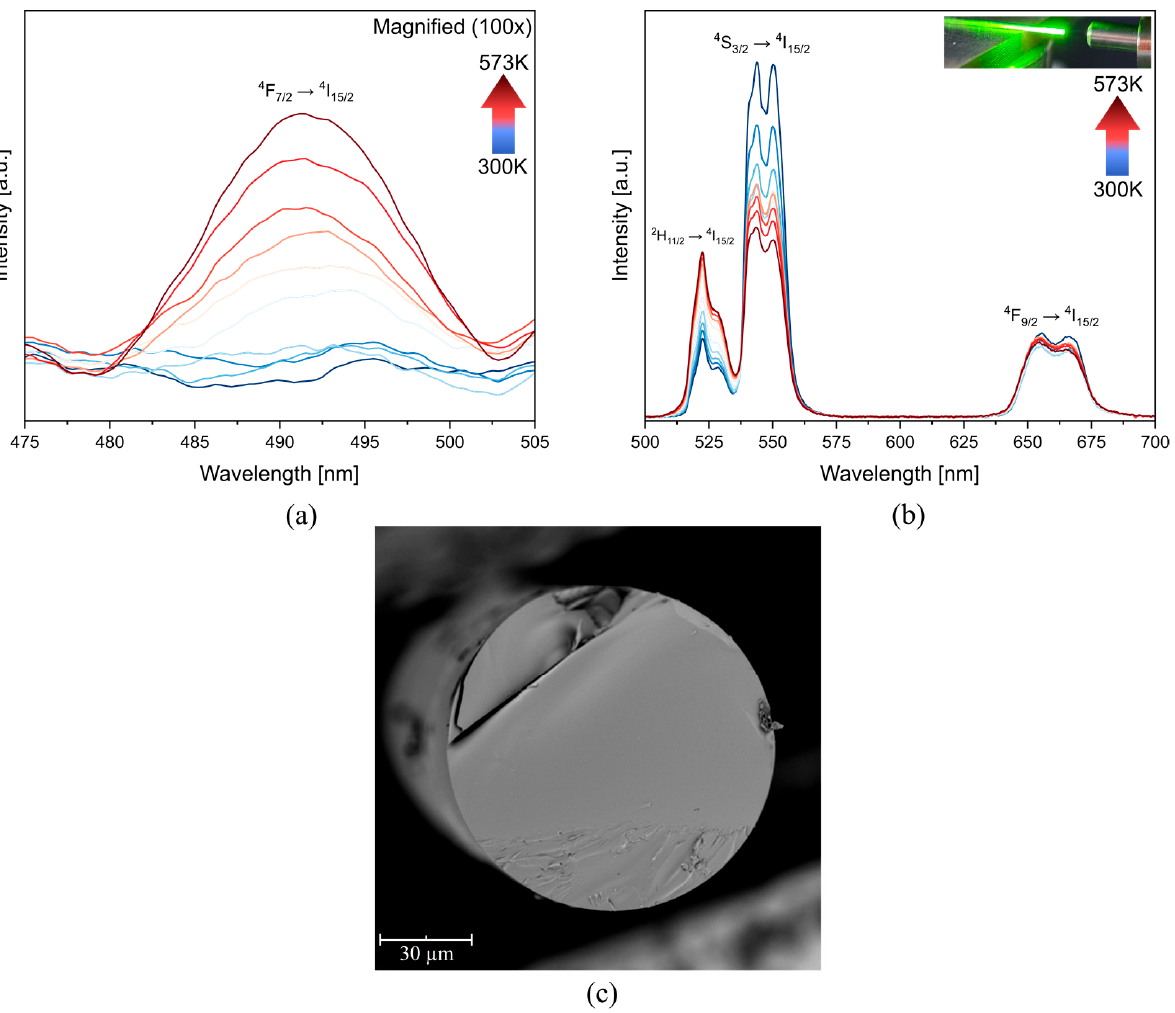
Figure 5. Up-conversion emission spectra of fluoroindate glass fiber co-doped with 0.8YbF 3 and 1.4ErF 3 under 980 nm excitation at the ( a ) 475–505 nm range (enlarge 100 times) ( b ) 500–700 nm range (inset—fiber under excitation) ( c ) SEM image of fiber cross-section. The FIR between 2 H 11/2 and 4 S 3/2 at room temperature is ~0.15 in both samples (Figure 6a). However, the ratio between the glass and fiberglass changes with the temper- ature. On the fiber, the FIR at 573 K is ~26.2% lower than on the glass for 2 H 11/2 — 4 S 3/2 , 4 F 7 F 4 F 2 H 2 H 4 S 7/2 — 9/2 , and 7/2 — 11/2 . The energy value between TCLs ( 11/2 and 3/2 ) is 620.2 cm − 1 (Figure